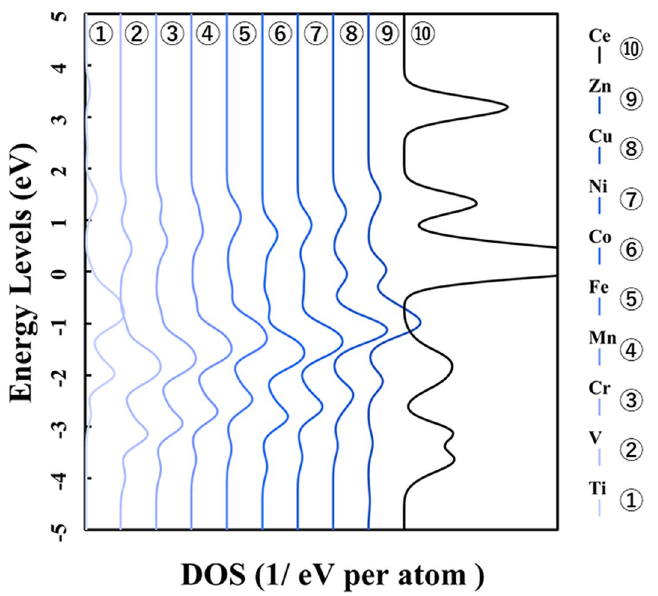
Figure 6. p-DOS for the 2p orbitals of the oxygen atoms in the M@Ce 12 O 836+ cluster model, the HOMO level in each M@Ce 12 O 836+ cluster model is the reference energy level. (M = Ti, V, Cr, Mn, Fe, Co, Ni, Cu, Zn,